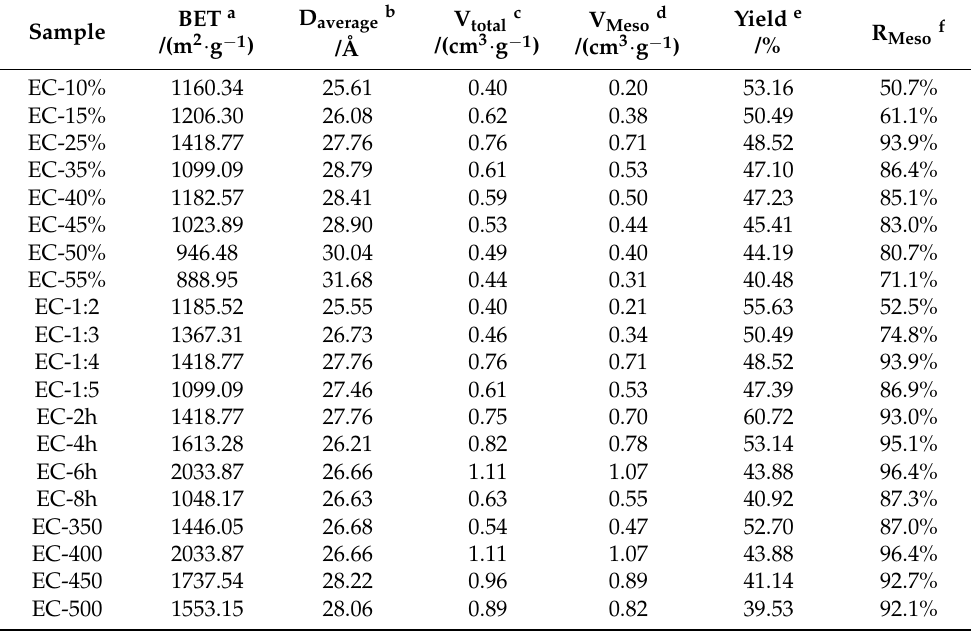
Table 2. Pore size distribution and yield of activated carbon in the different activation